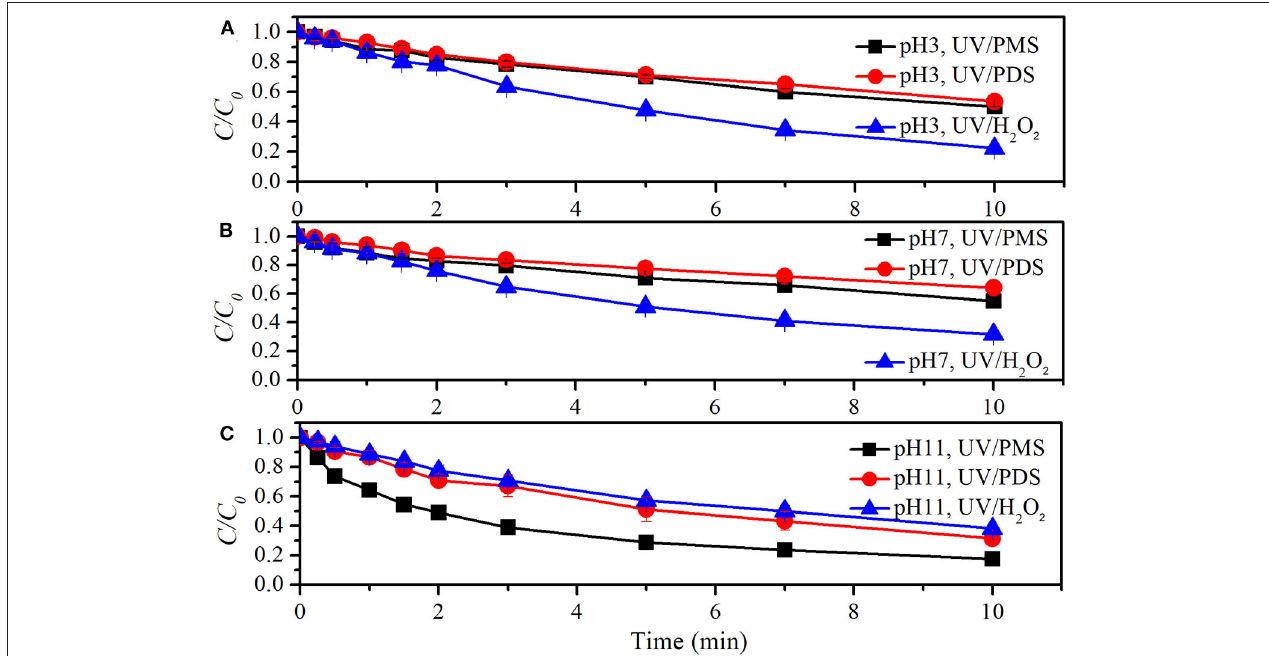
FIGURE 5 | Degradation efficiencies of NB by UV/PMS, UV/PDS, and UV/H 2 O 2 (A) at pH 3, (B) at pH 7, and (C) at pH 11. Conditions: 0.6L, I 0 = 1.7 × 10 − 6 Einsteins · s − 1 , [PB] = 2mM, [NB] = 6.6 µ M, [PMS] = 100 µ M as 1/2 Oxone, [PDS] = 100 µ M, [H 2 O 2 ] = 100 µ M, 25 ◦ C.